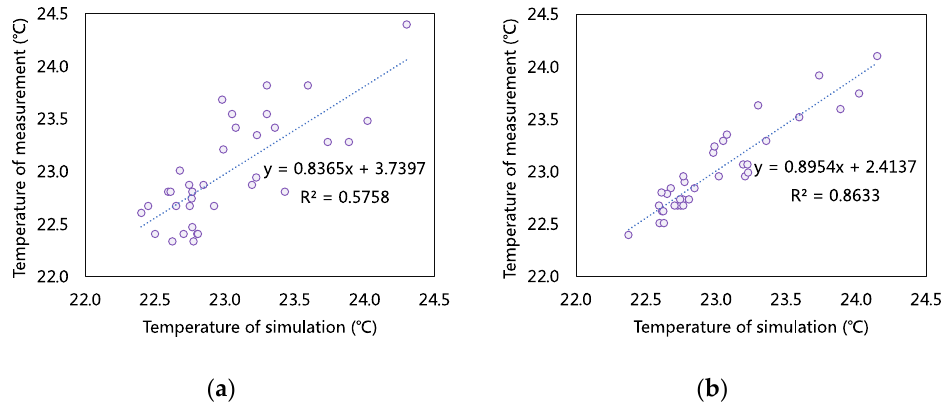
Figure 14. Simulation results of temperature in ( a ) simplified diffuser model and ( b ) detailed diffuser model.